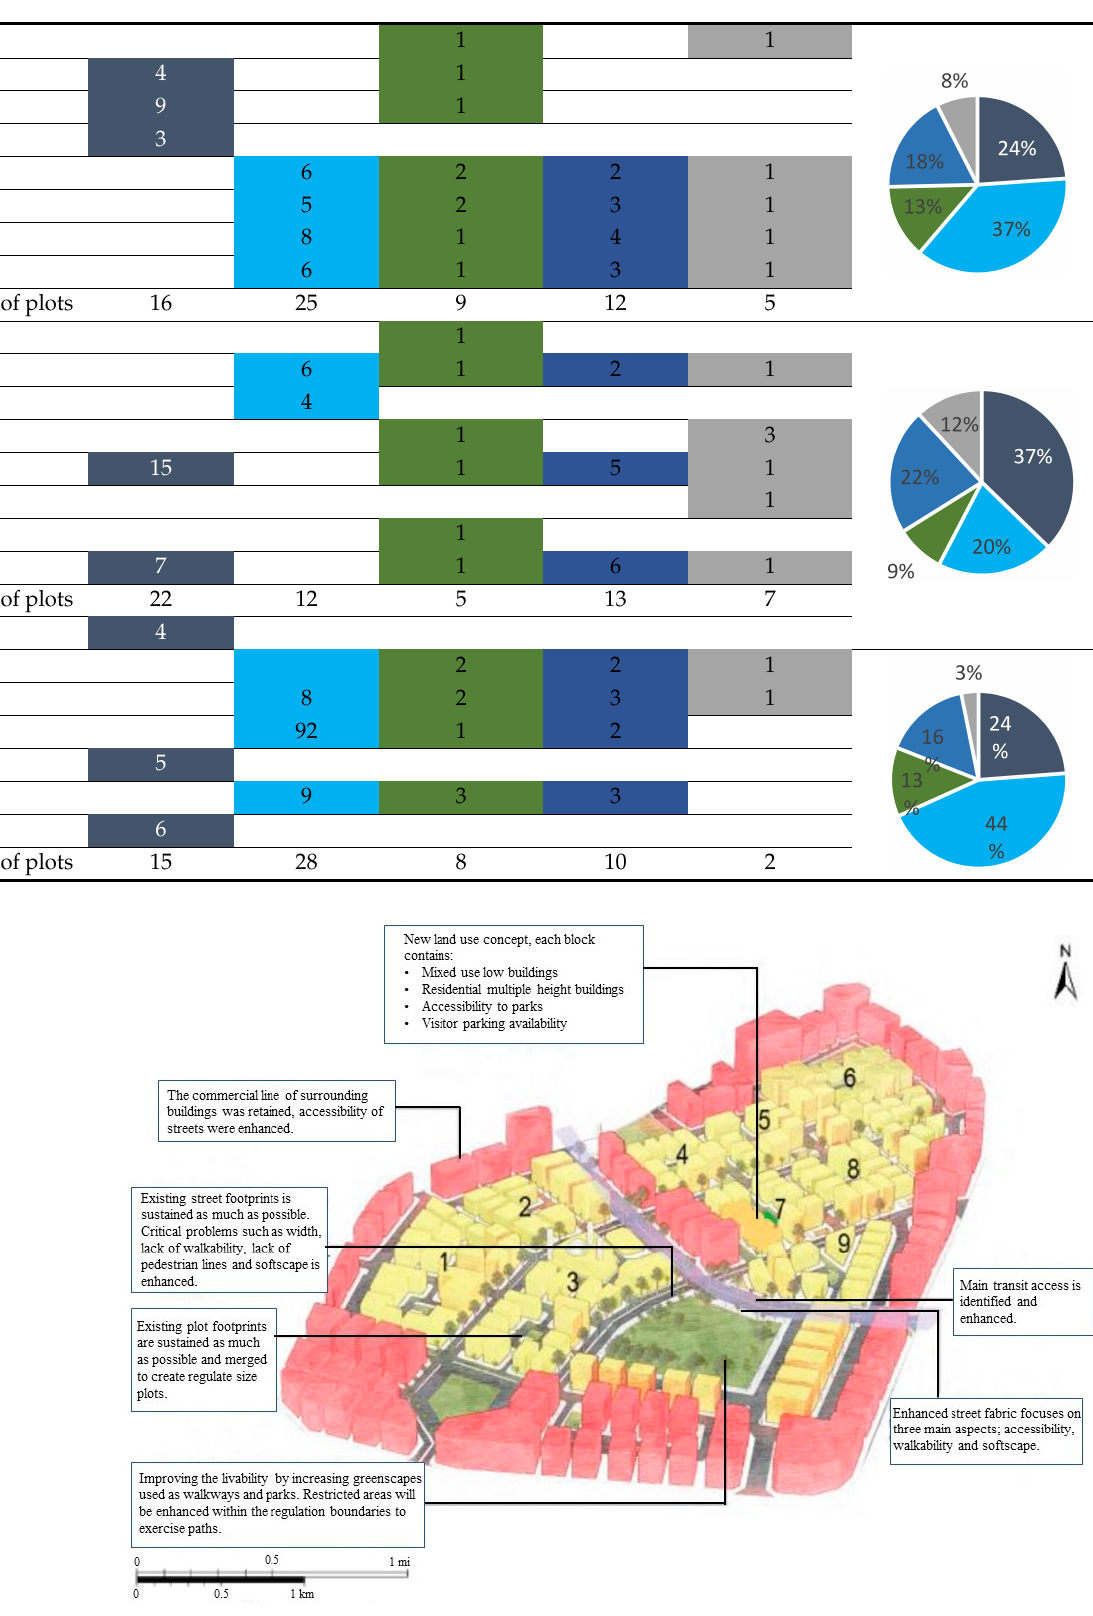
Figure 5. Proposed improvements on the block level in the Al Ghanim District (Source: the Au- thors).